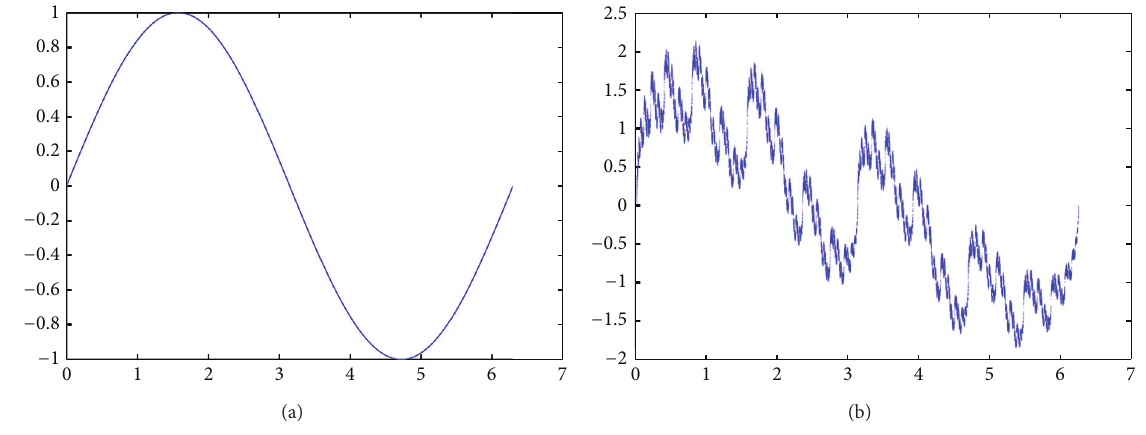
Figure 3: The graph of 𝑔(𝑥) in Example 9 and the graph of 𝑔 𝛼 (𝑥) with 𝜆 1 = 0.4 and 𝜆 2 = 0.6